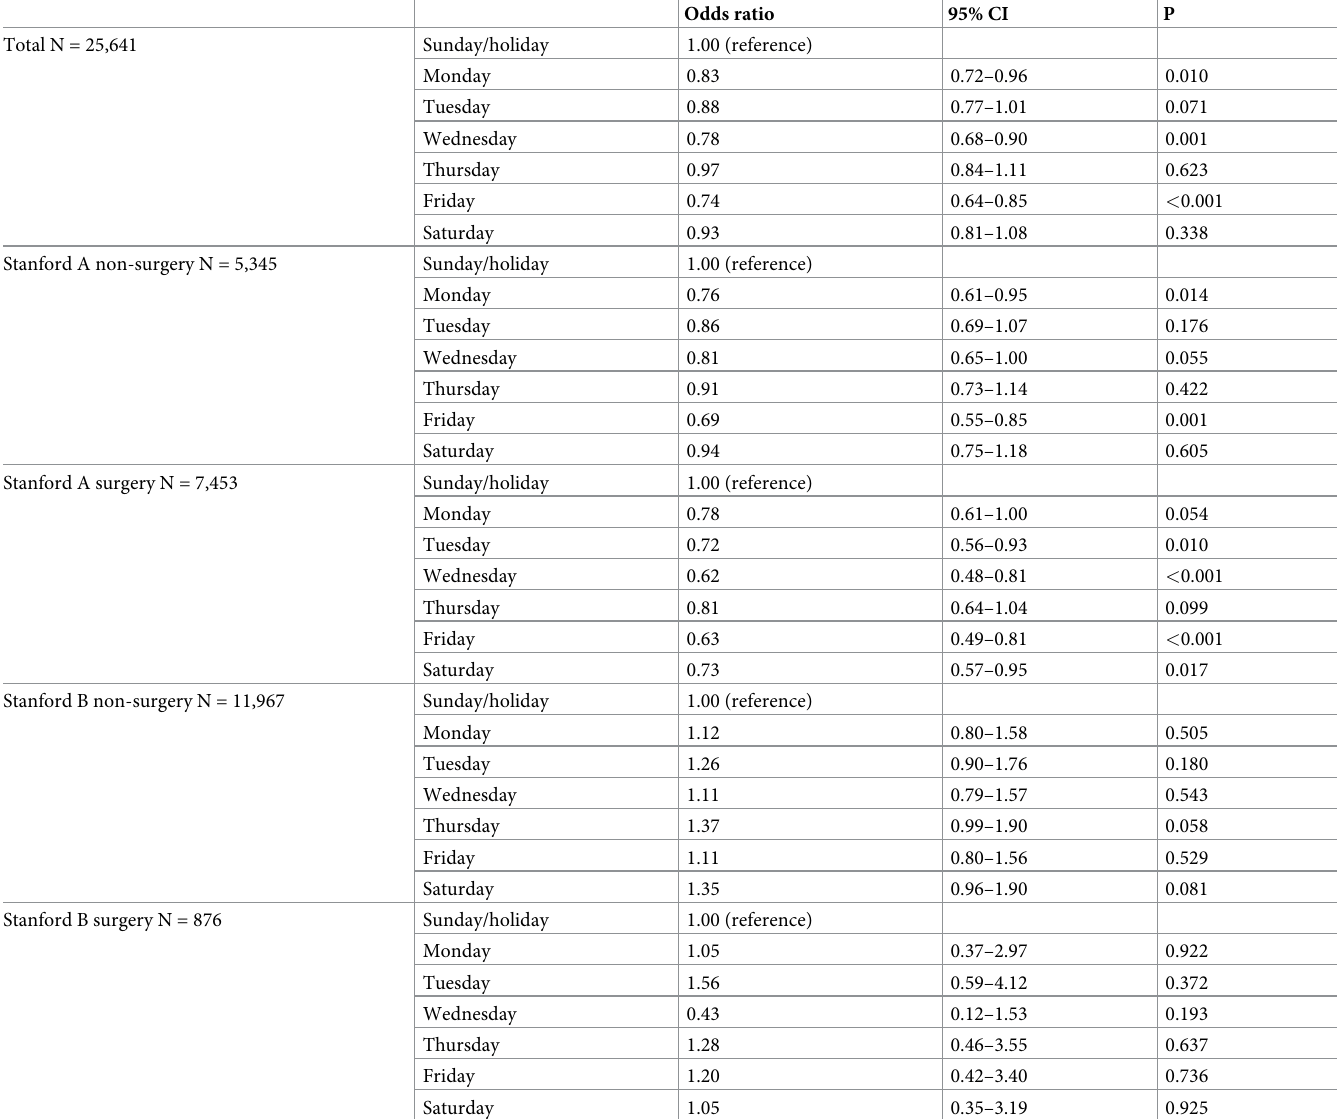
Table 4. In-hospital mortality per 7